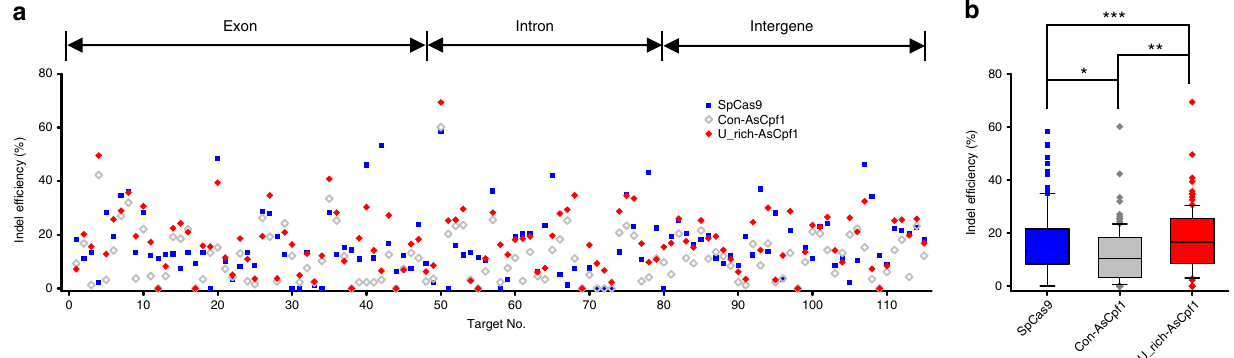
Fig. 3 Large-scale comparison of the genome-editing ef fi ciencies of CRISPR-AsCpf1 and CRISPR-SpCas9. a A dot plot of the indel ef fi ciencies of AsCpf1 and SpCas9 in HEK-293T cells. The indel ef fi ciencies of AsCpf1 and SpCas9 were compared on common targets with a sequence of 5 ′ -TTTV(N) 20 NGG-3 ′ , where V is A, C, or G. For the AsCpf1 activity, the conventional crRNA (for con-AsCpf1) con fi guration was compared with our optimized U-rich crRNA (for Opt-AsCpf1). b A box-and-whisker plot for the indel ef fi ciencies of AsCpf1 and SpCas9. The graph consists of median values, lower and upper quartile, and outer standard deviations. * p = 0.003, ** p = 0.00003, *** p = 0.29, two-tailed Student ’ s t